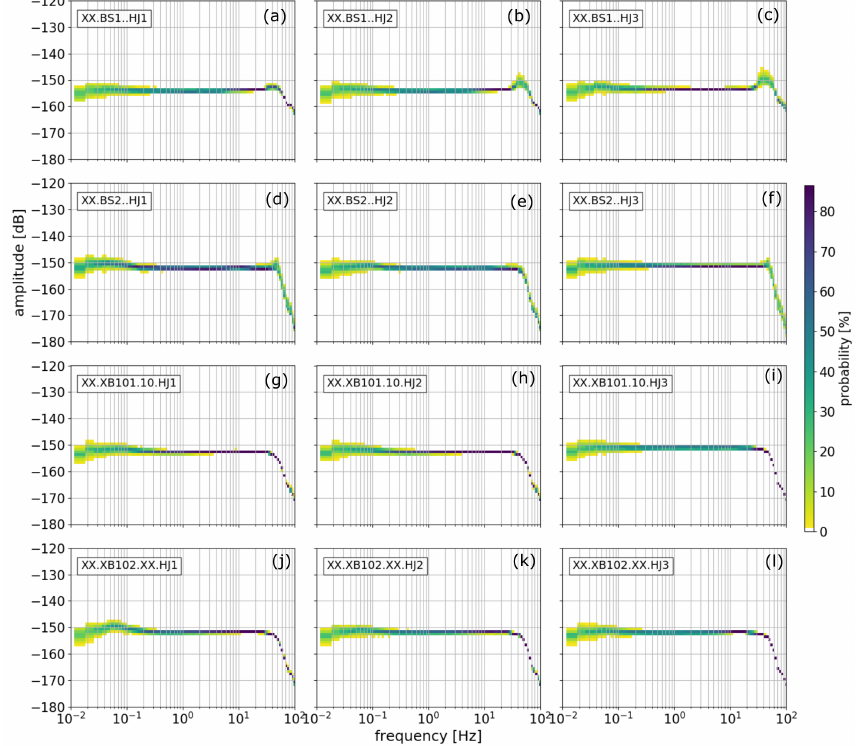
Figure 3. Probabilistic power spectral densities for all three components of all five instruments for 1 September, Sunday. Panel content like in Figure